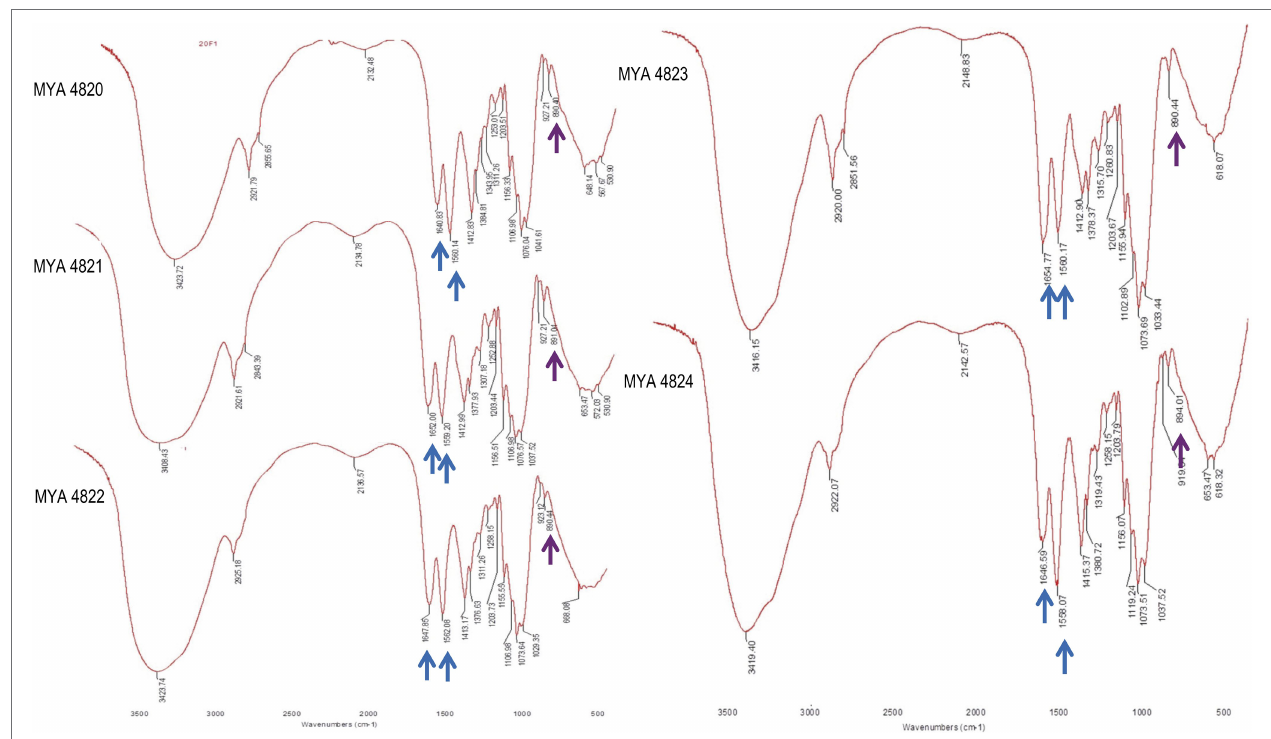
FIGURE 1 | Sporothrix schenckii strains IR spectra of alkali-insoluble polysaccharides. Here, the signals corresponding to all strains are shown. Chitin and β -glucan signals are indicated with blue and purple arrows respectively, also are present signals of β -glucans (1,3 and 1,6 evidenced by peaks at 1156, 1076, and 1,041 cm − 1